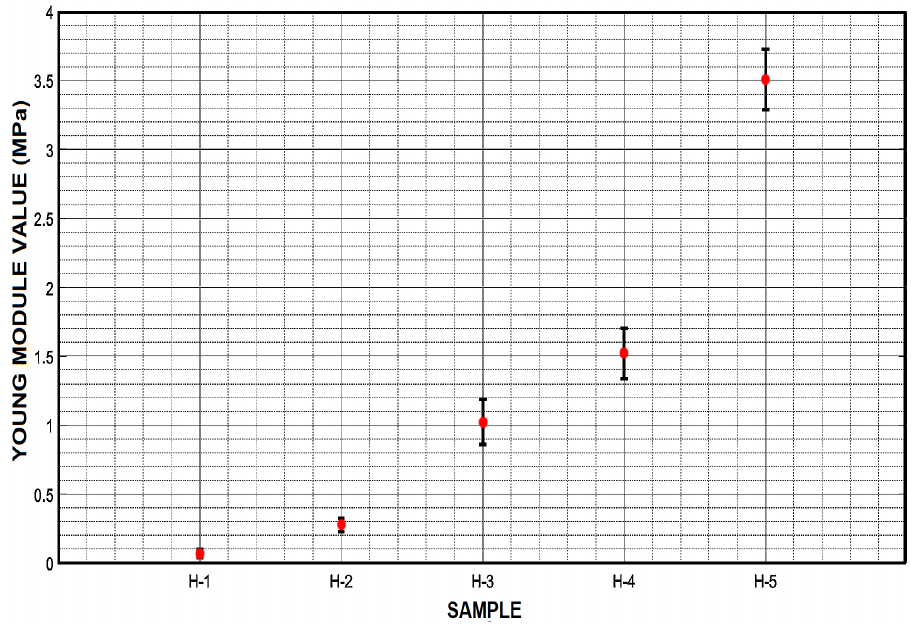
Figure 17. Young’s modulus of the three samples shows a great difference in their ability to behave as an elastic material, being H-1 the most elastic sample and H-5 the strongest sample, triplicate the value of